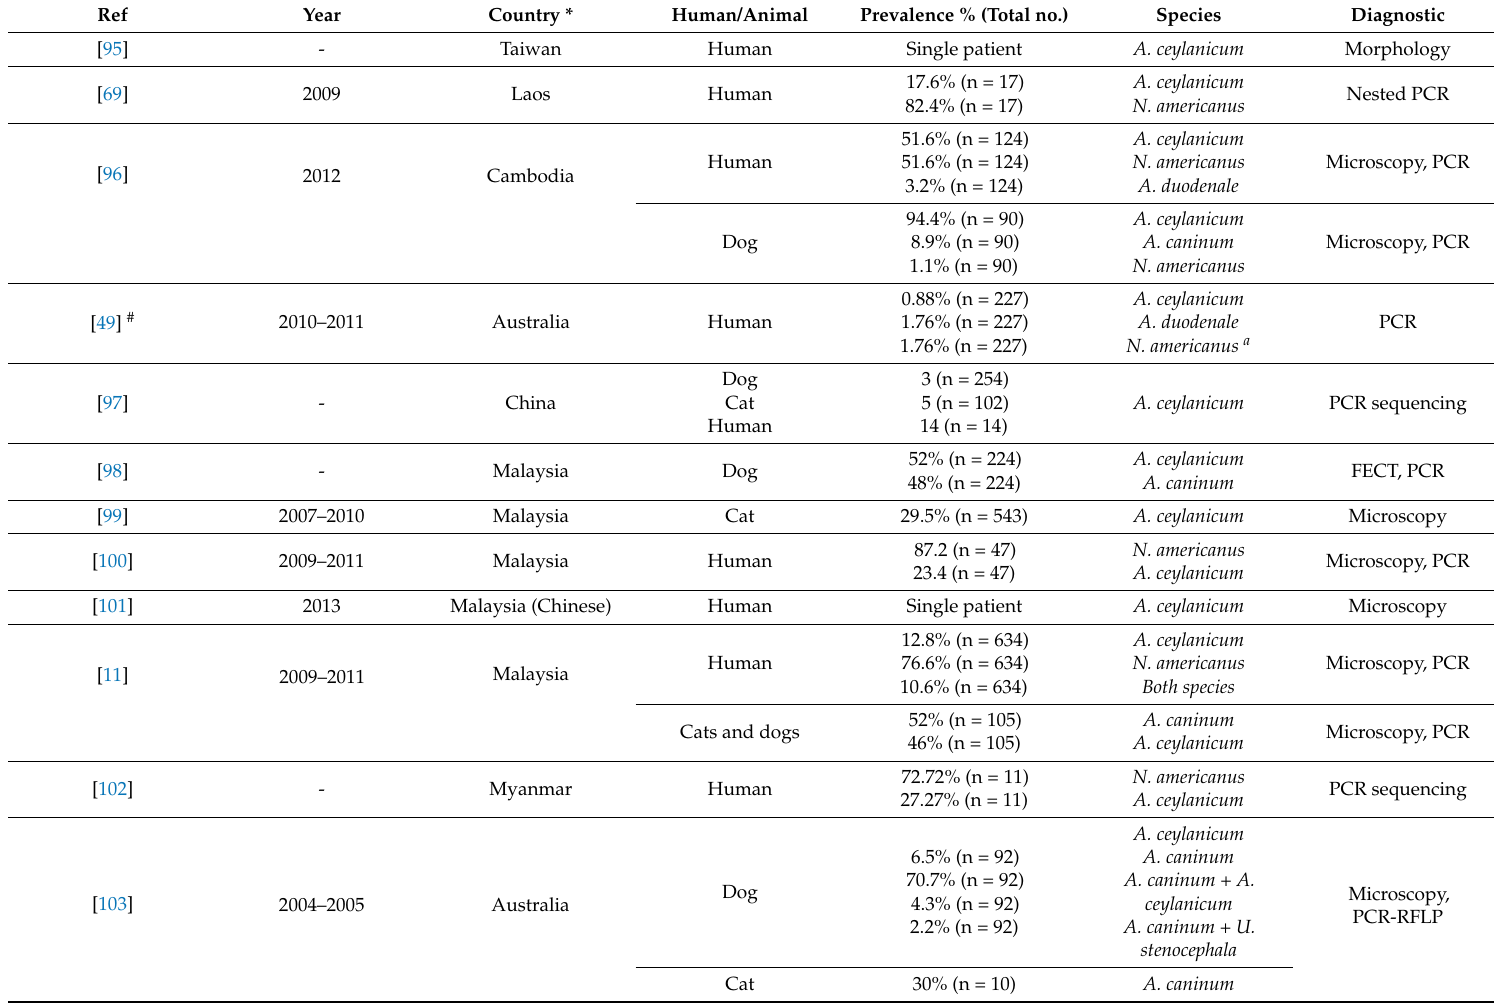
Table 2. Reported prevalences of A. ceylanicum human and animal infections in studies conducted in Australia and Asia since